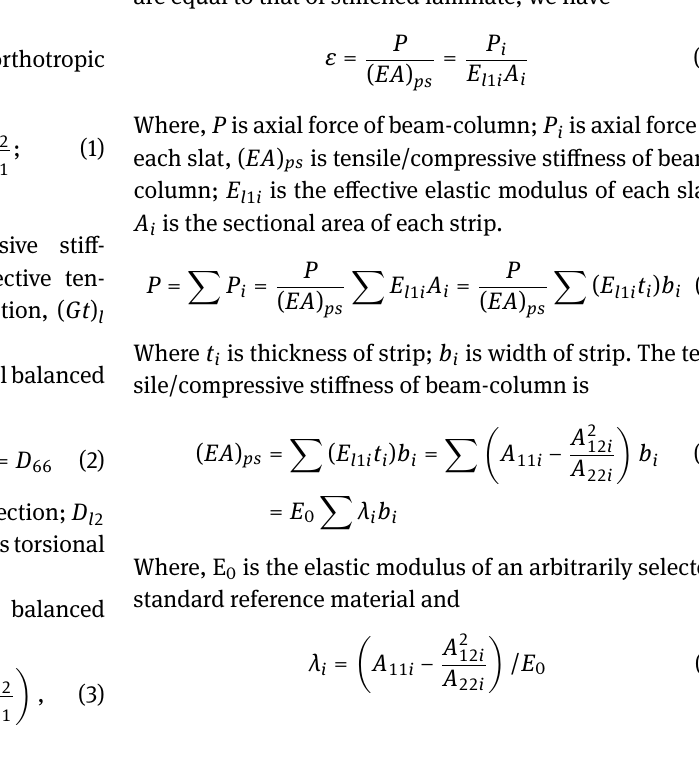
Figure 1: Hull girder section